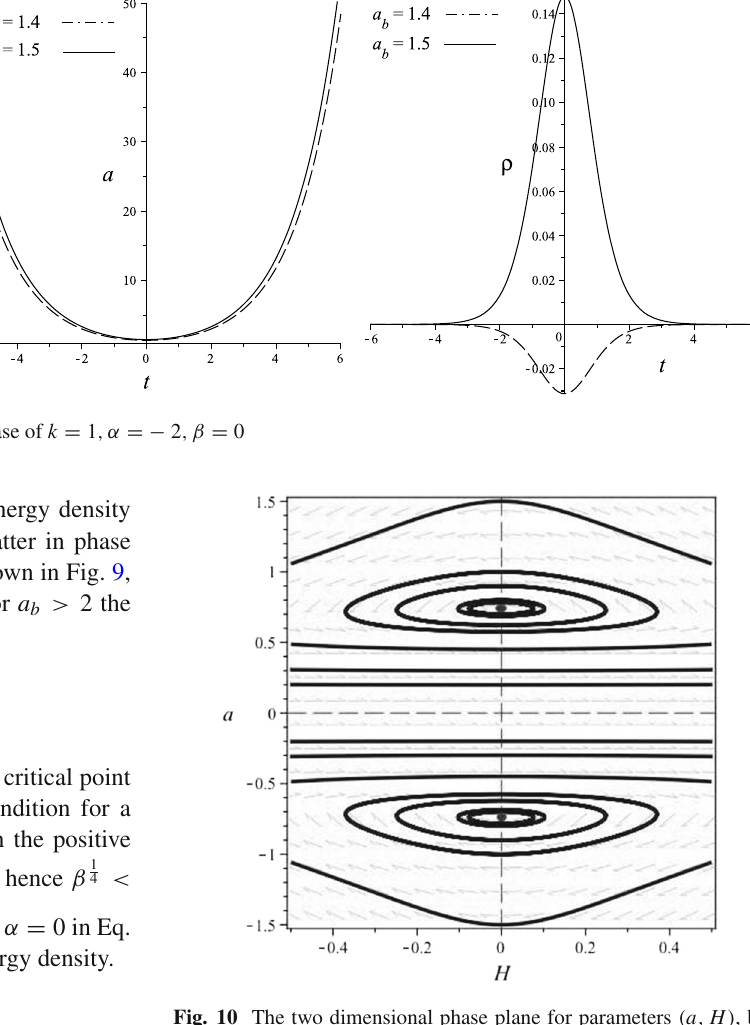
Fig. 10 The two dimensional phase plane for parameters ( a , H ) , by setting α = 0, β = − 0 .